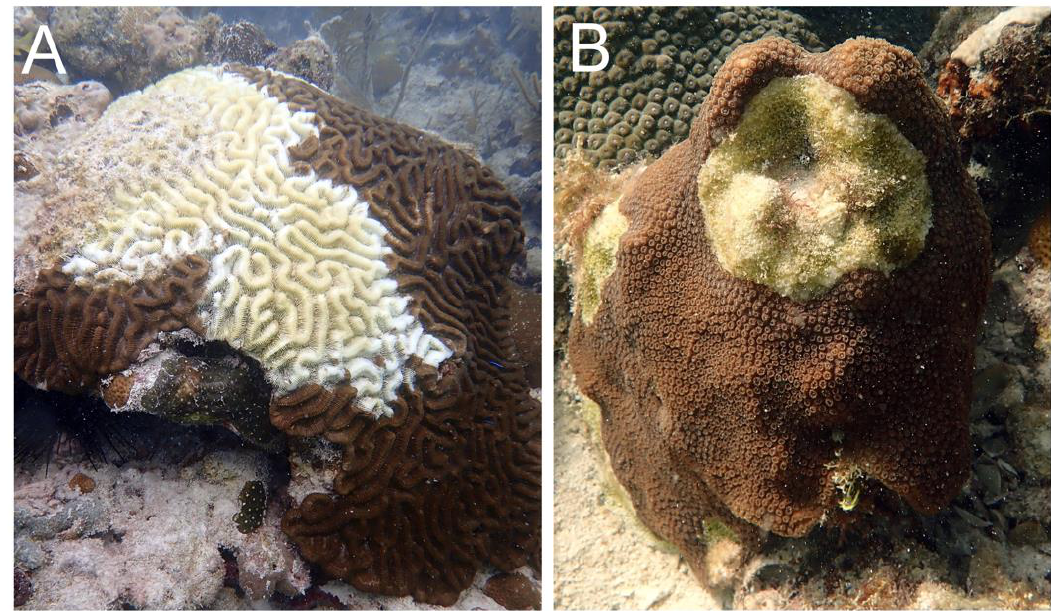
Figure 2. Representative photos of colonies with stony coral tissue loss disease (SCTLD). ( A ) Colpophyllia natans with acute tissue loss and ( B ) Orbicella faveolata with chronic tissue loss.